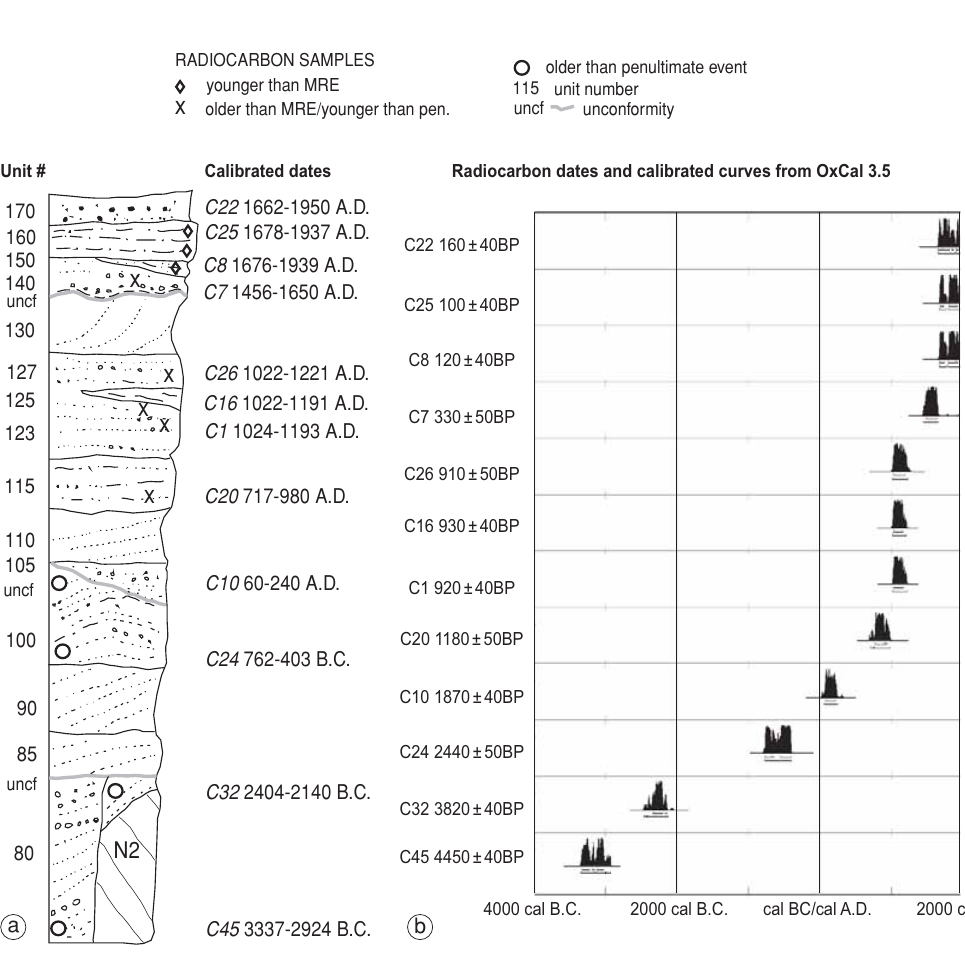
Fig. 7a,b. a) Stratigraphic column of Camel trench showing relative unit thickness, unit number, major uncon- formities, and stratigraphic location of radiocarbon samples. Diamonds show dates above the MRE, Xs show dates older than the MRE, and Os are older than the penultimate event. Weak evidence in the trench near fault zone 2 suggests an event at the level of unit 125. b) Probability distributions for calendar dates determined from the radiocarbon age for each sample using OxCal v3.5 (Ramsey,